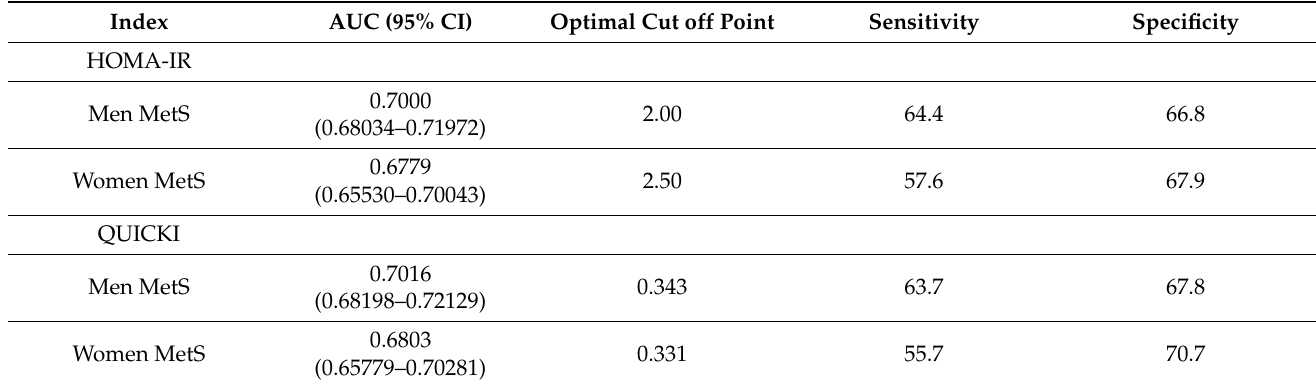
Table 2. HOMA-IR and QUICKI cut off